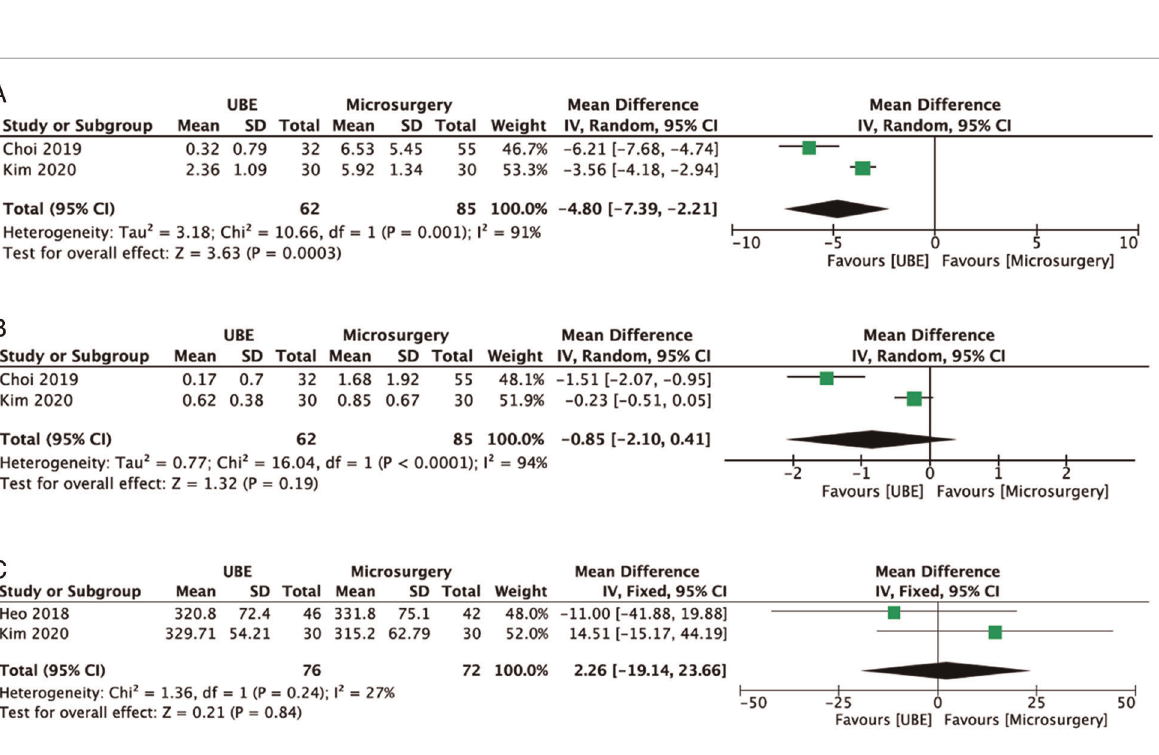
FIGURE 9 Forest plots comparing CRP level at 2-day after surgery ( A ) and 1-week after surgery ( B ), and postoperative dural expansion ( C ) between UBE ULBD and microscopic ULBD. CRP, C-reactive protein; UBE, unilateral biportal endoscopic; ULBD, unilateral laminectomy with bilateral decompression.